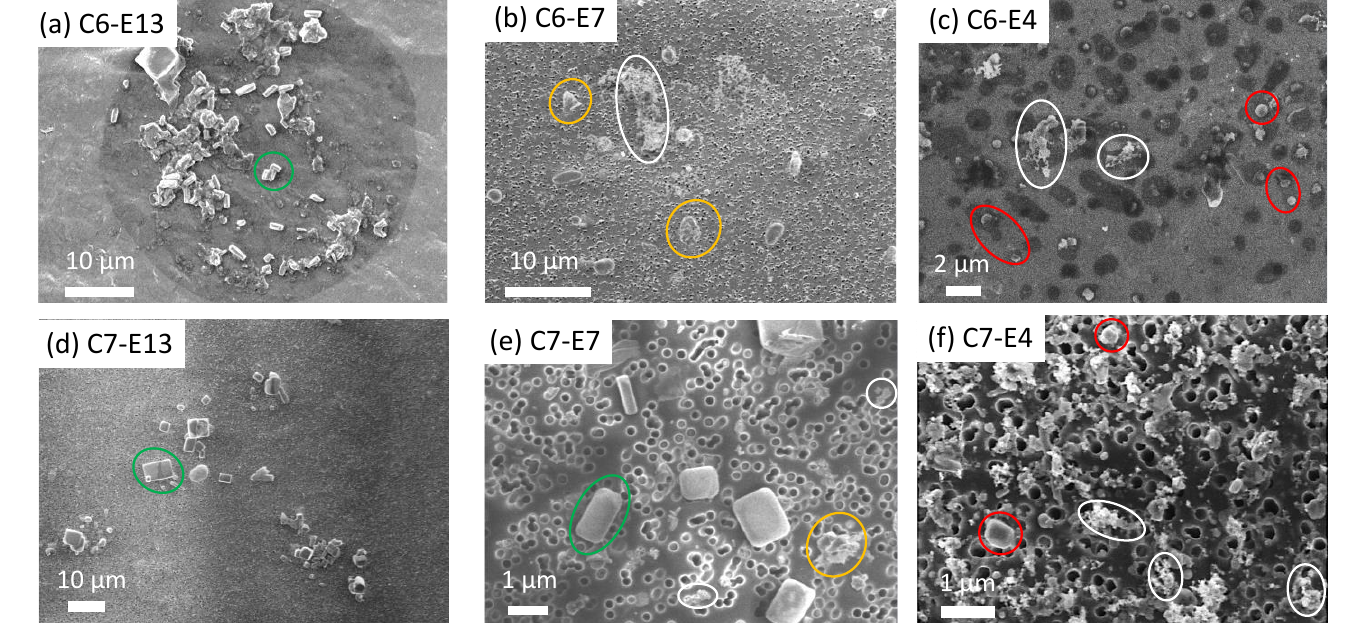
Figure 9. SEM images of the coarse (E13), intermediate (E7) and fine (E4) modes stages of samples C6 ( a – c ), and C7 ( d – f ) of Le Croisic. The coarse modes ( a , d ) are made of NaCl salt crystals (green circles), the intermediate modes ( b , e ) of a mixture of salts, large soot aggregates (white circles), and minerals (orange circles), and the fine modes ( c , f ) of soot and sulfate particles (red circles).